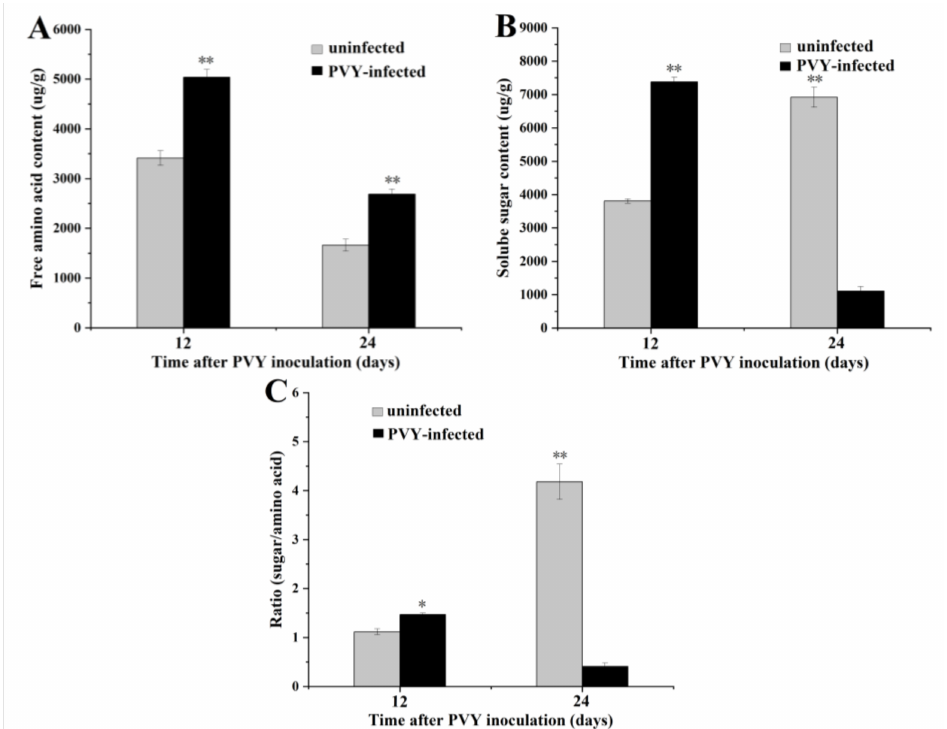
Figure 3. Nutrient analysis of free amino acids and soluble sugars in the leaf tissues of uninfected and PVY-infected tobacco plants. ( A )—total free amino acid content; ( B )—total soluble sugar content; C —sugar: amino acid ratio. * p < 0.05 and ** p <